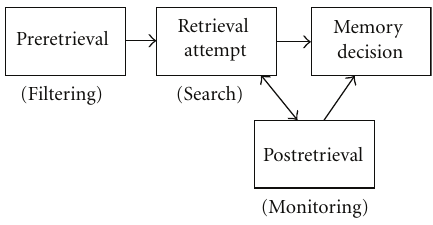
Figure 2: Stages of memory retrieval leading up to a memory decision. Preretrieval processes filter out irrelevant information to constrain the memory search. A retrieval attempt is made. If prere- trieval processing is insu ffi cient, postretrieval processing is engaged to edit or elaborate on retrieved content prior to making a memory decision. Bidirectional arrows between retrieval attempt and postre- trieval reflect the possibility of additional retrieval attempts prior to the memory